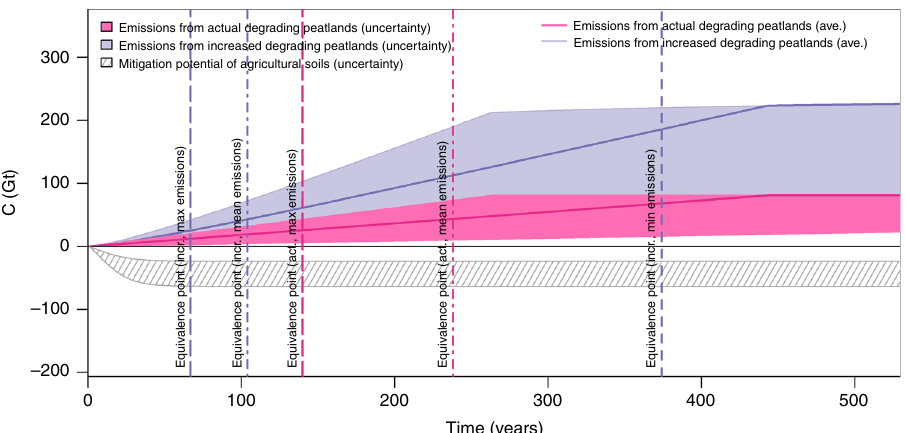
Fig. 3 The world ’ s cumulative GHG emissions from degrading peatlands. Cumulative emissions of the current area are in pink, and for a doubling of that area within 60 years (future scenario, see Methods) in blue (positive values). Their end points represent the theoretical maximum that can be emitted from the degrading peat C stocks. Units are Gt CO 2 -C-eq. Negative areas display the cumulated C sink in mineral soils assuming the C saturation equation proposed by ref. 31 (gray). Vertical lines denote equivalence points where mineral soil sink potentials are exhausted relative to peatland-related emissions (minimum, average and maximum estimates, for numbers see text; maximum equivalence point for actual degrading peatland is 1021 years and not